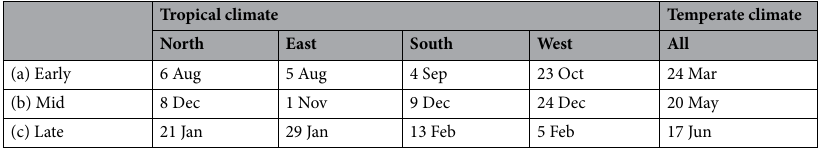
Table 2. Typical starting date for vector control defined when the mosquito population a) is at its lowest (Early release), b) begins to increase (Mid release) and c) has reached its maximum (Late